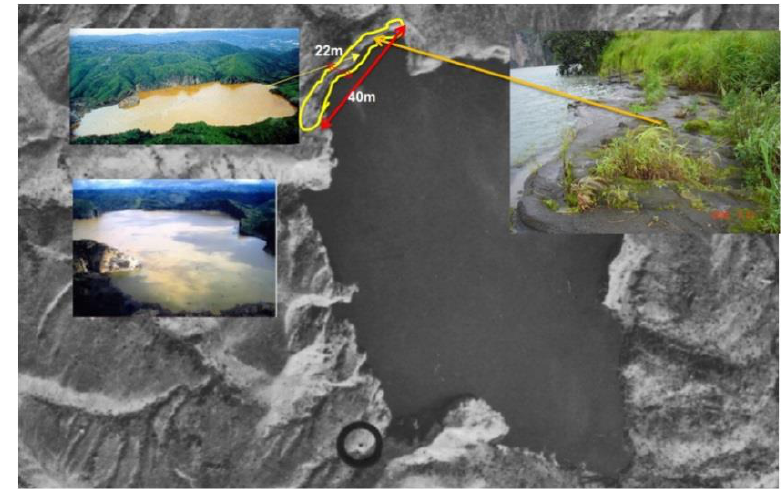
Figure 10. Lake Nyos pyroclastic dam (from aerial photographs). This dam is only 22 m across and 40 m long. 40 m